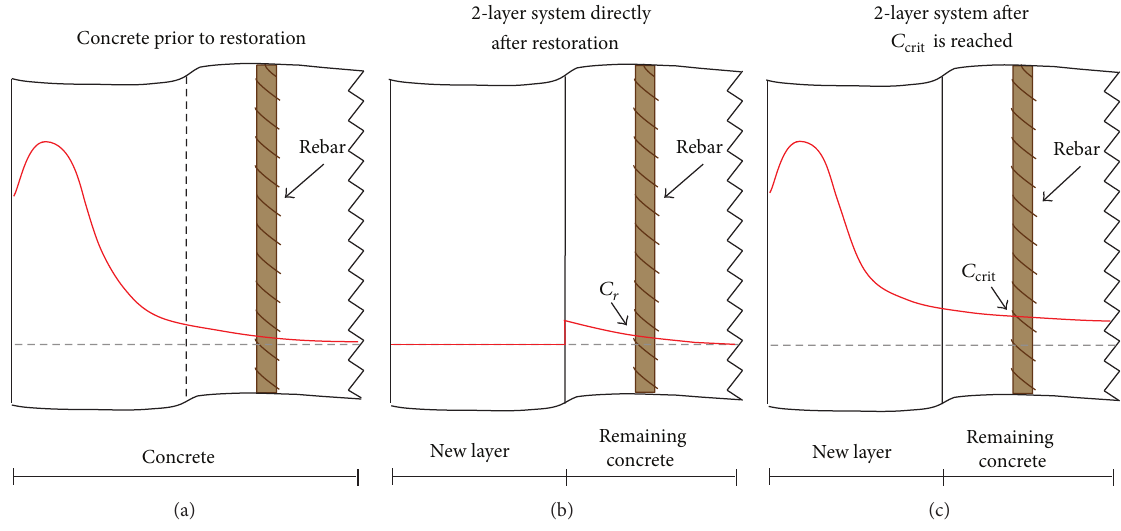
Figure 6: Schematic representation of the chloride profiles in a repaired concrete structural element.